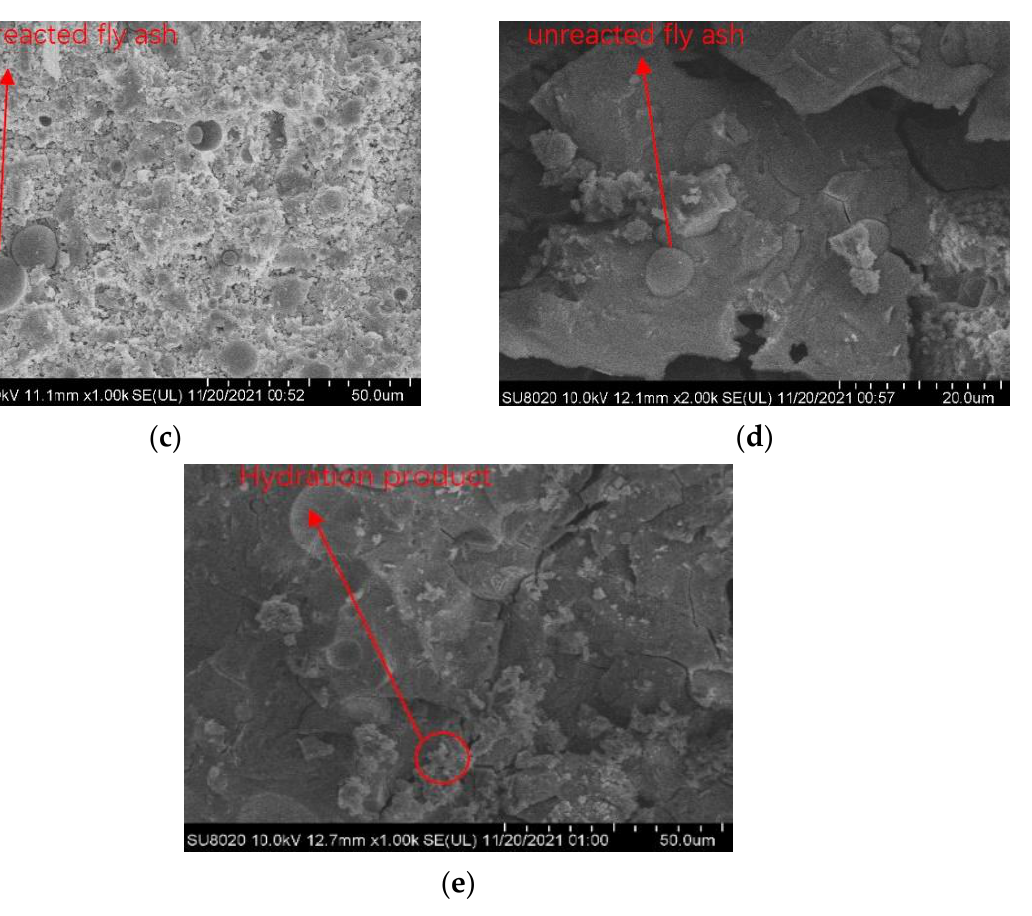
Figure 6. The scanning electron micrographs: ( a ) 3 days; ( b ) 7 days; ( c ) 28 days; ( d ) Scheme 1; ( e ) Scheme 2.